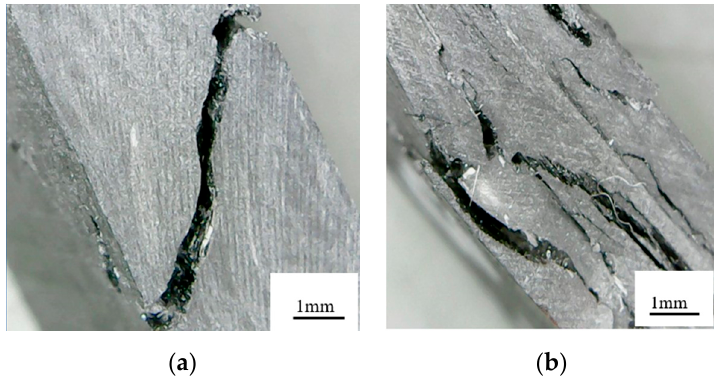
Figure 15. Edge fracture state of ( a ) 1 mm composite, ( b ) 25 mm composite.